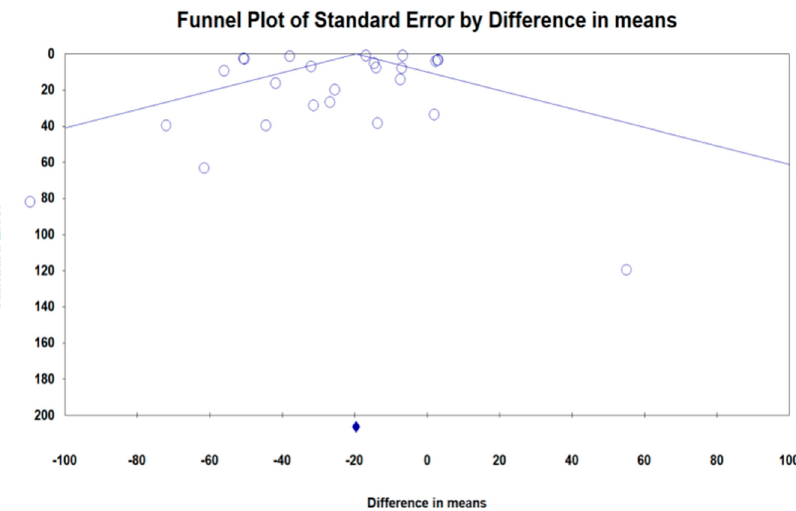
Figure 6. Funnel plot detailing publication bias in the publications describing the effect of BS on MCP-1. on